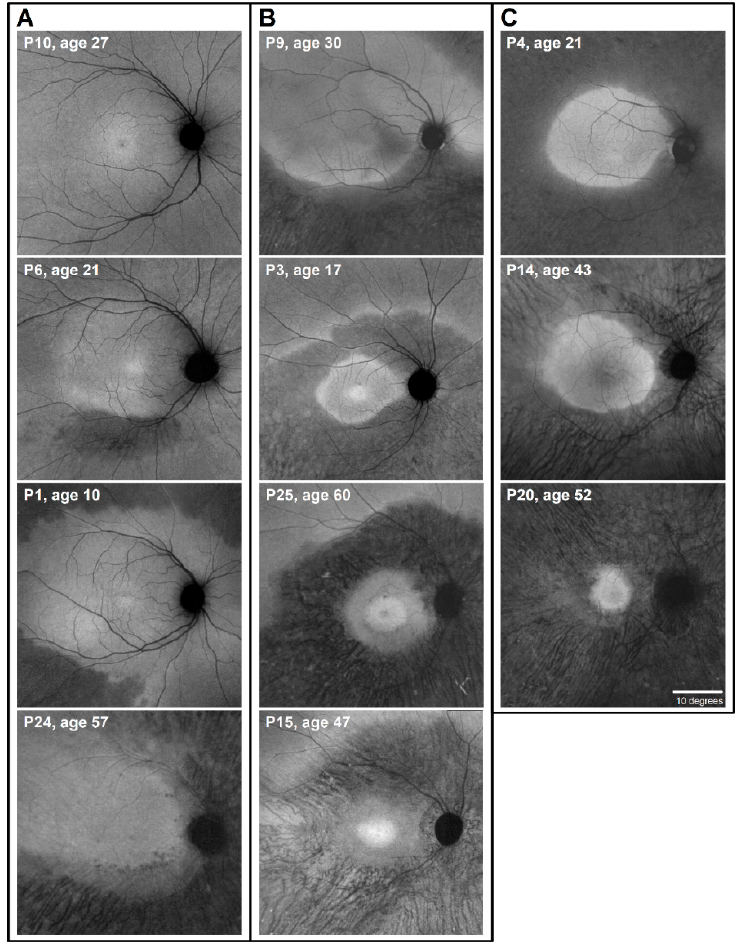
Figure 1. Topography of retinal pigment epithelial (RPE) disease in RHO -adRP. ( A ) Series of en face near-infrared (NIR) autofluoresence (AF) images (all displayed as right eyes for ready comparison) illustrating the spectrum from little or no RPE disease (P10); an abnormal pericentral inferior retinal region (P6); inferior and superior pericentral–midperipheral disease but sparing the nasal inferior retina (P1); and a more extensive inferior, nasal, and superior disease with superior temporal retention (P24). ( B ) Further images showing inferior retinal abnormalities and some superior nasal disease (P9); a pericentral ring of disease with inferior retinal extension at further eccentricities (P3); another pericentral ring with greater inferior abnormalities (P25); pericentral and greater inferior than superior retinal disease (P15). Different from the patients in ( A ) are the abnormalities in the central retina of patients in ( B ) and the considerable constriction of the central island in P15. ( C ) Patients with a larger central island surrounded by RPE disease (P4, P14). The retained central island of RPE is small in P20, and surrounding RPE is abnormal across the full extent of the image. Scale bar = 10 degrees.